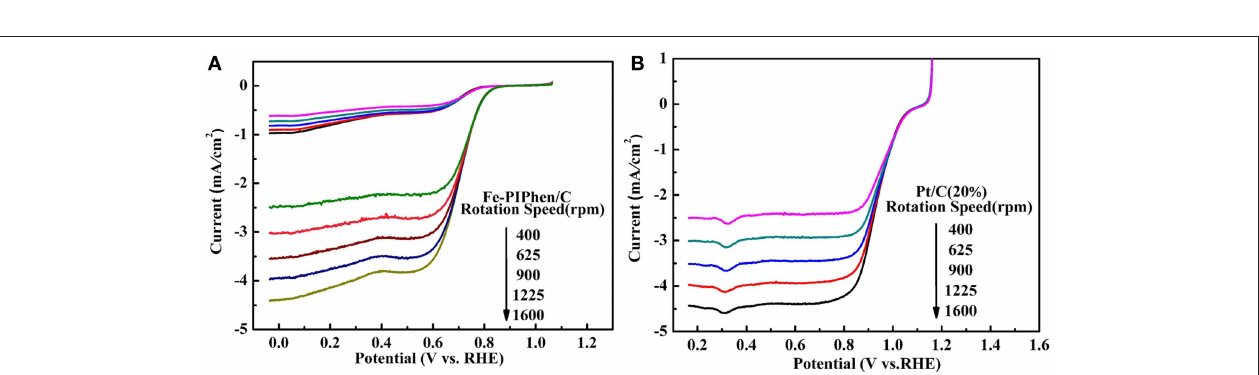
FIGURE 6 | The CV curves of Fe-PIPhen/C (A) in nitrogen and oxygen saturated KOH (0.1M) solution, CV of Fe-PIPhen/C and Pt/C (20% content) in KOH saturated and O 2 (B) , repeated CV curves of Fe-PIPhen/C (C) measured in oxygen saturated electrolyte for stability tests. Scan rate: 100 mV/s.